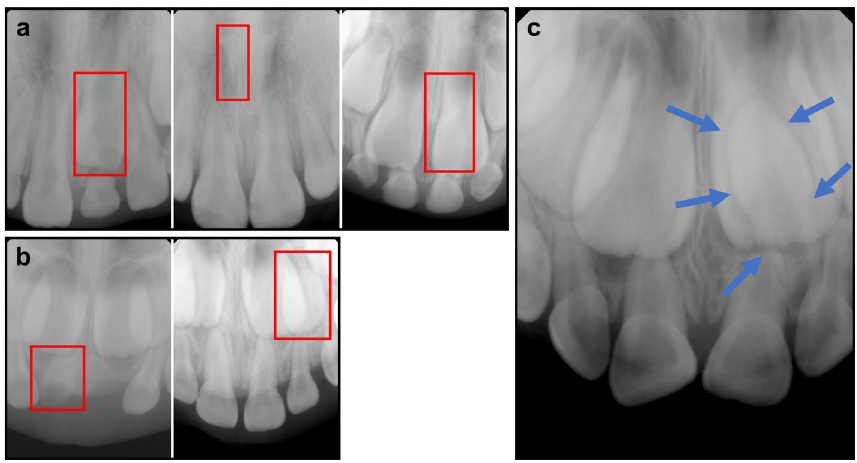
Figure 8. False-positive cases and a false-negative case. False-positive cases misdiagnosed as mesiodens in the YOLOv3 model ( a ) and the RetinaNet model ( b ), and a false-negative case in the EfficientDet-D3 model ( c ). Red boxes indicate the regions that were incorrectly detected as mesiodens, while blue arrows indicate undetected